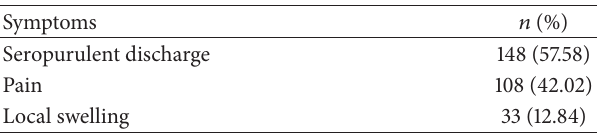
Table 1: Preoperative symptoms.